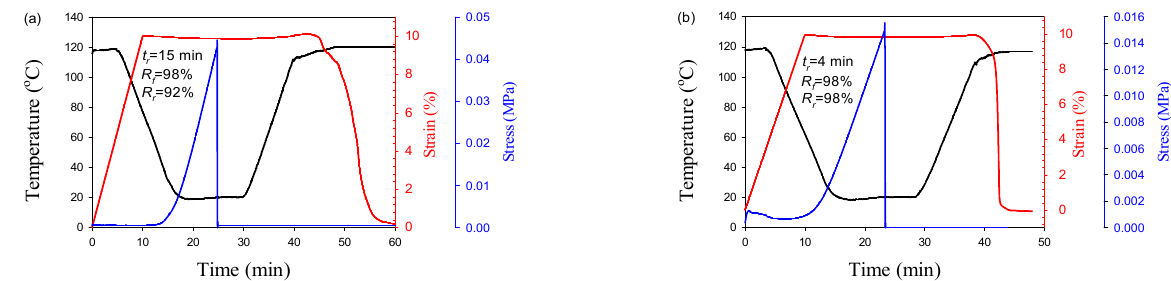
Figure 6. Temperature and strain of PLA/PBAT/CNFs blends ( a ) and in situ generated composites ( b ) during dual shape memory cycle. T d = 120 °C. CNFs—7 wt.%.